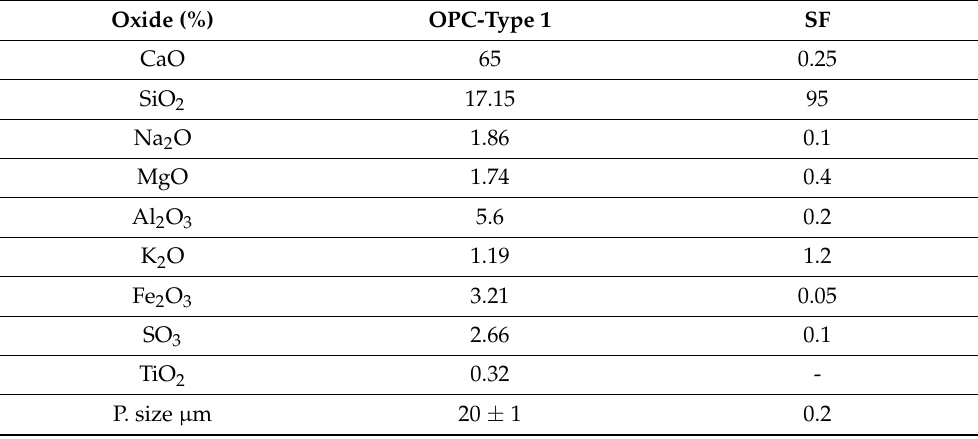
Table 2. Chemical Composition of Cement and Silica Fume.